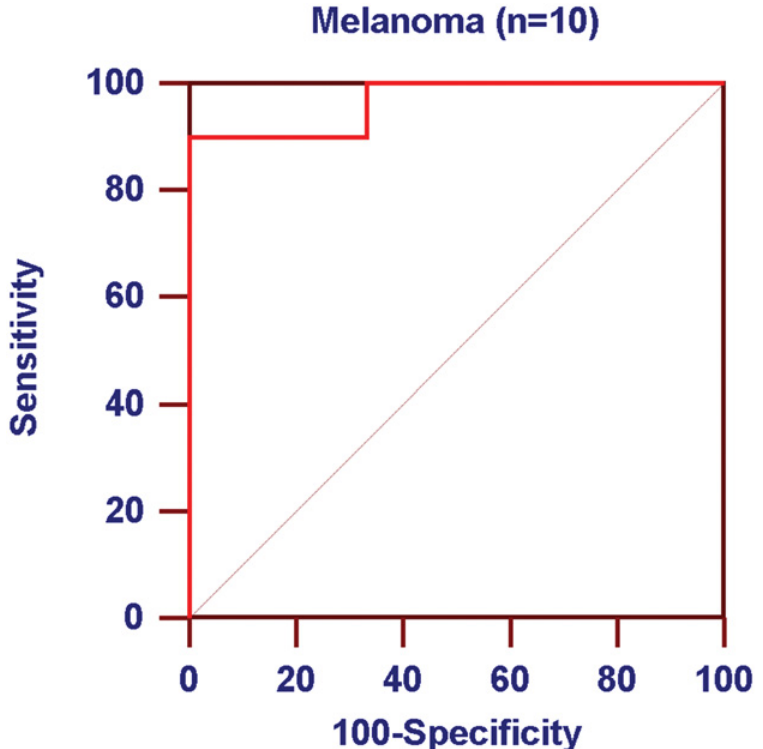
Fig 3. ROC curve demonstrating favorable telomerase-based CTC assay test characteristics for identifying patients with and without melanoma. A CTC count threshold of 1.1 CTCs/mL results in sensitivity of 90.0% and specificity of 91.7%. Analysis was performed using blood samples from 10 melanoma patients and 6 controls.